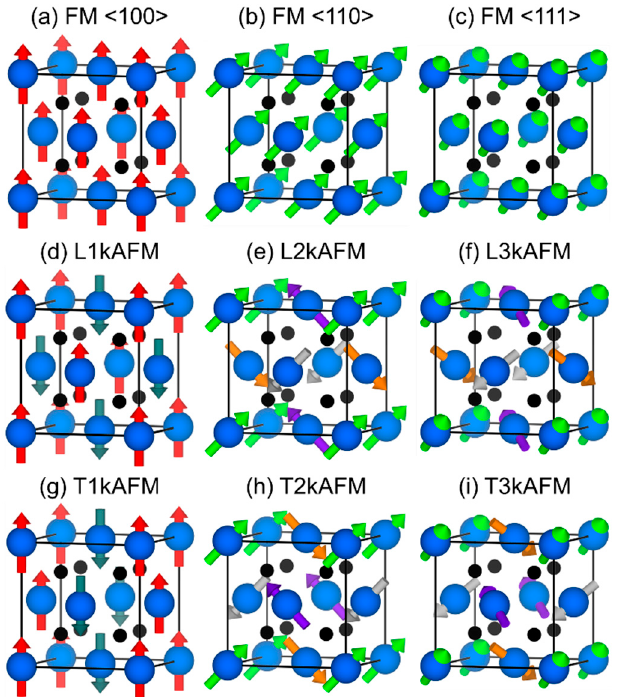
Figure 2. Magnetic structure of cubic PuH x with FM ( a ) <100>, ( b ) <110>, ( c ) <111>, longitudinal AFM ( d ) 1k, ( e ) 2k, ( f ) 3k, and transverse AFM ( g ) 1k, ( h ) 2k and ( i ) 3k. Pu in blue and H occupying tetrahedral sites (H T ) in black for PuH 2 . The presence of H occupying octahedral sites (H O ) in PuH 3 would not change the directions of the magnetisation on Pu atoms.